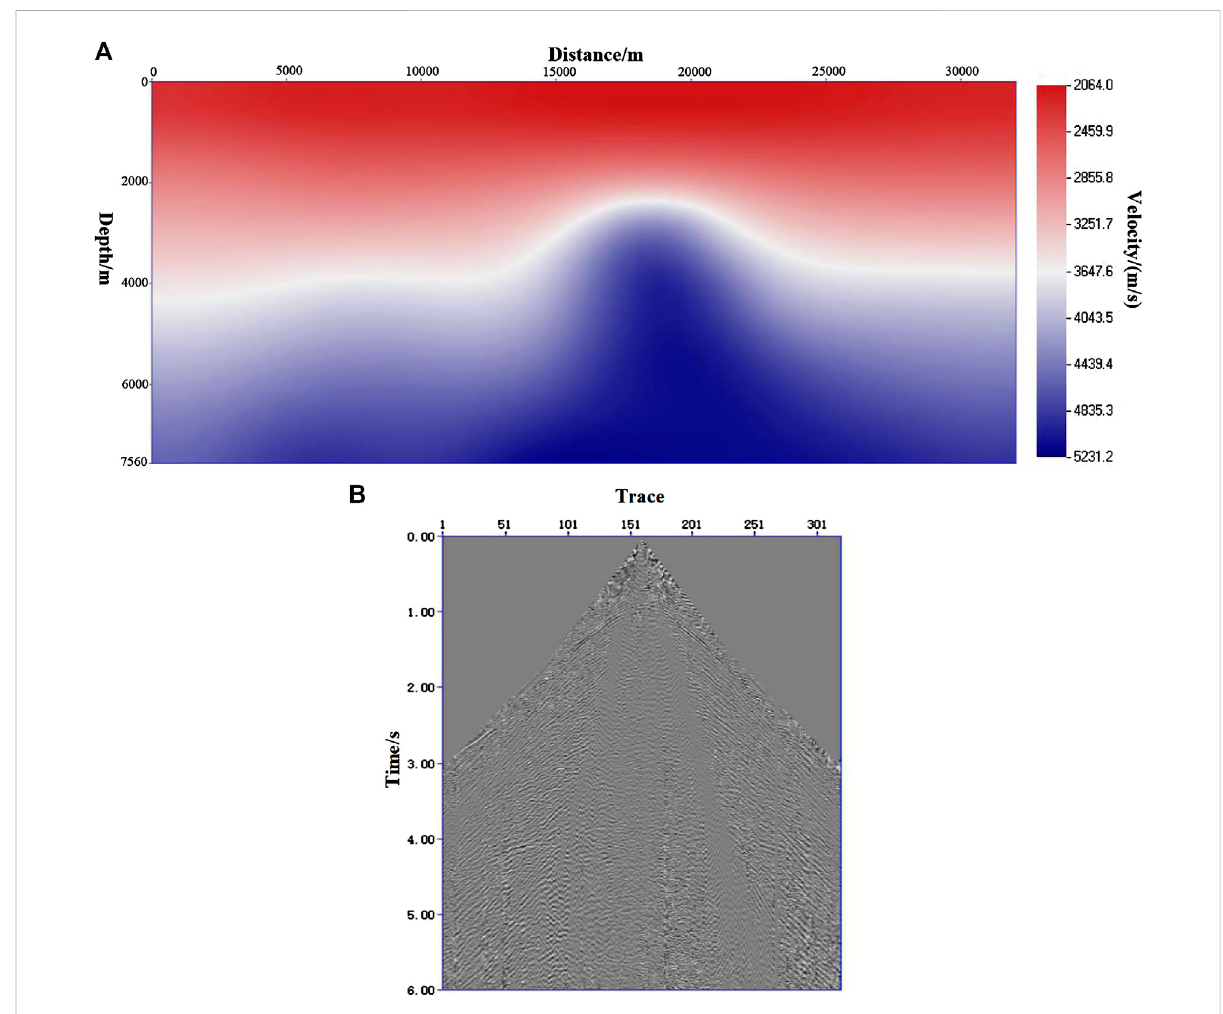
FIGURE 7 Velocity fi eld of fi eld seismic data and single-shot